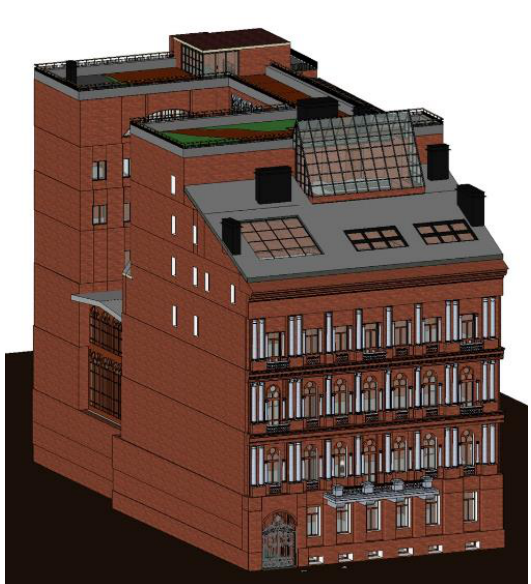
Figure 6. As-built BIM-model for historical heritage case